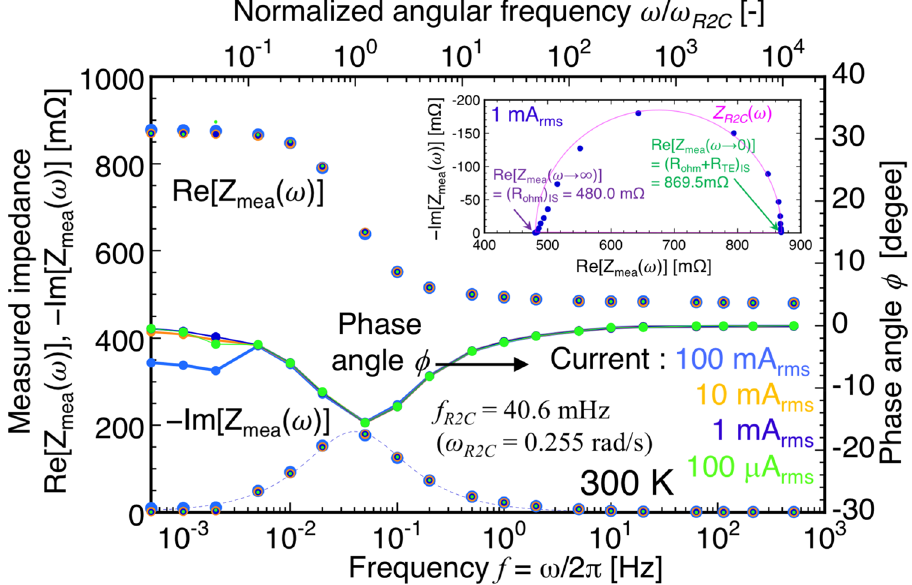
Figure 2. Frequency dependence of impedance of real Re[ Z mea ( ω )] and imaginary part − Im[ Z mea ( ω )], respectively and phase angle ϕ at each AC (100 μA rms to 100 mA rms ) for the TM prepared. The upper axis shows normalized angular frequency ω / ω R2C . A lock-in amplifier and Quasi-AC method (implemented using a high- precision AC source and digital multimeter using real-time data acquisition for the low-frequency region) 12,28 were applied to measure the impedances at frequencies more than and less than 10 mHz, respectively. An inset shows its Nyquist plot of Z R2C ( ω ) and fitting plot by R2C approximation given in Eq. (2).